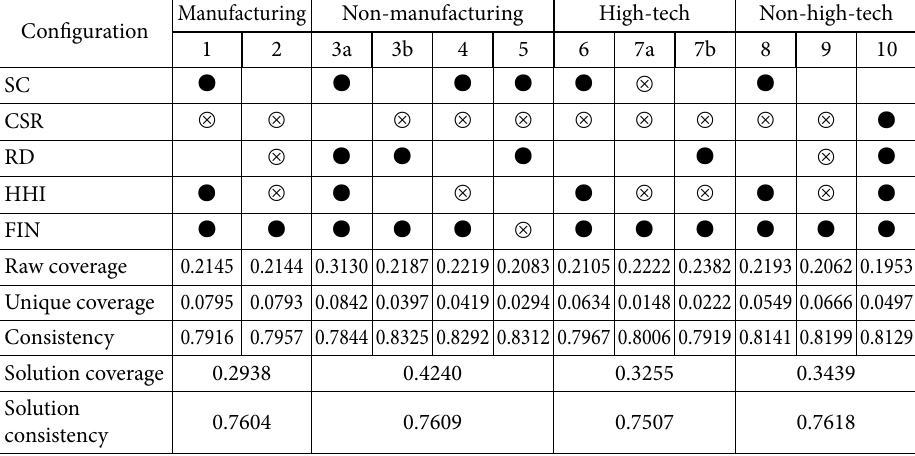
Table 10. Configurations leading to high-level risk-taking of different industry corporates